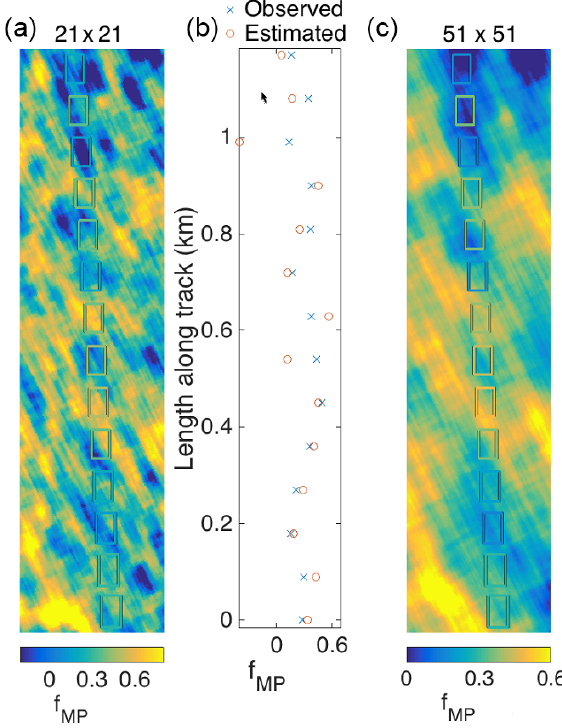
Figure 10. Melt pond fraction ( f MP ) estimated from σ 0 the observed f MP from the helicopter images overlaid as coloured frames. The area displayed is 0 . 3 × 1 . 1km and its position is out- lined with a frame in Fig. 9. The estimation is performed with 21 × 21 (left) and 51 × 51 (right) pixel windows. Note that the centre pixel underlying each helicopter image frame would give the most representative value for comparison to the observed f MP , as pixels Figure 9. Top: probability density distributions of f MP for the in- closer to the frame contain a larger amount of information from out- vestigated floe in T4. Curves represent distributions produced by the side the frame. The middle panel displays the mean estimated f MP regression fit based on σ 0 with 21 × 21 and 51 × 51 pixel windows, VV value for each frame together with the observed and observed distributions from all helicopter flights (regional) and from the specific floe (floe). Bottom: estimated f MP from the σ 0 - VV based regression with a 51 × 51 pixel window for investigated floe in T4. The frame outlines the area displayed in Fig. 10.